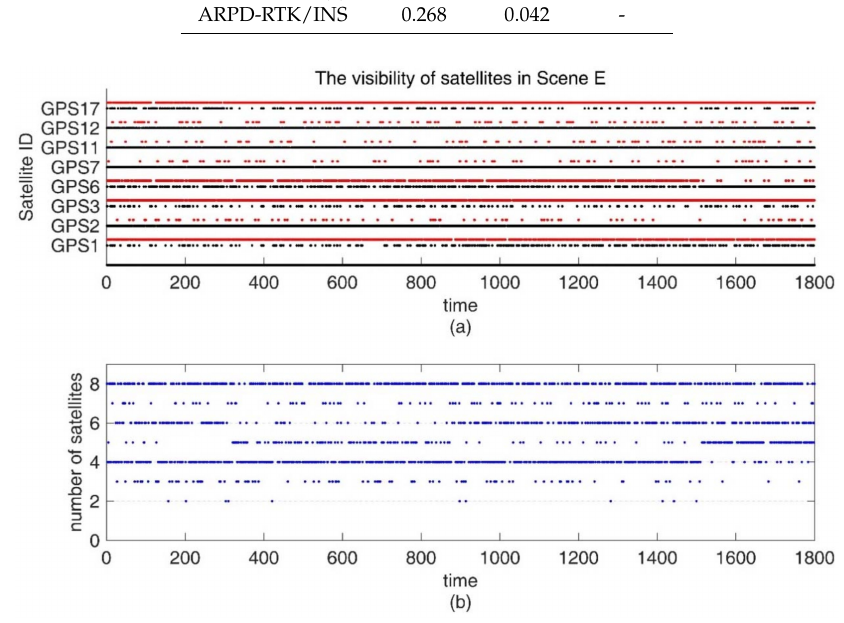
Figure 10. ( a ) The satellite visibility of the 1800 s simulation data for Scene E; ( b ) The number of satellites in Scene